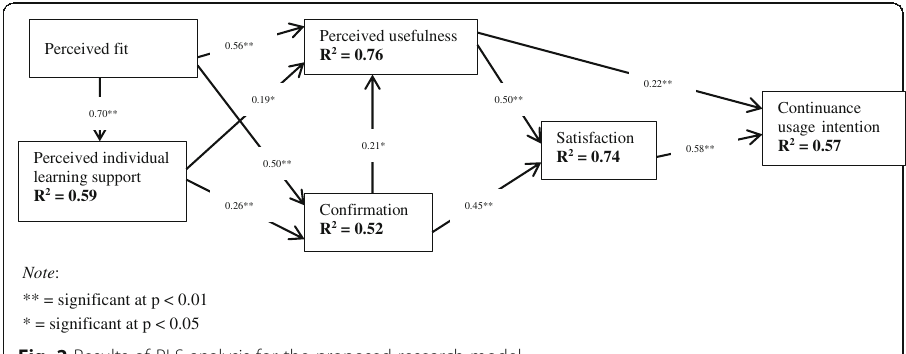
Fig. 2 Results of PLS analysis for the proposed research